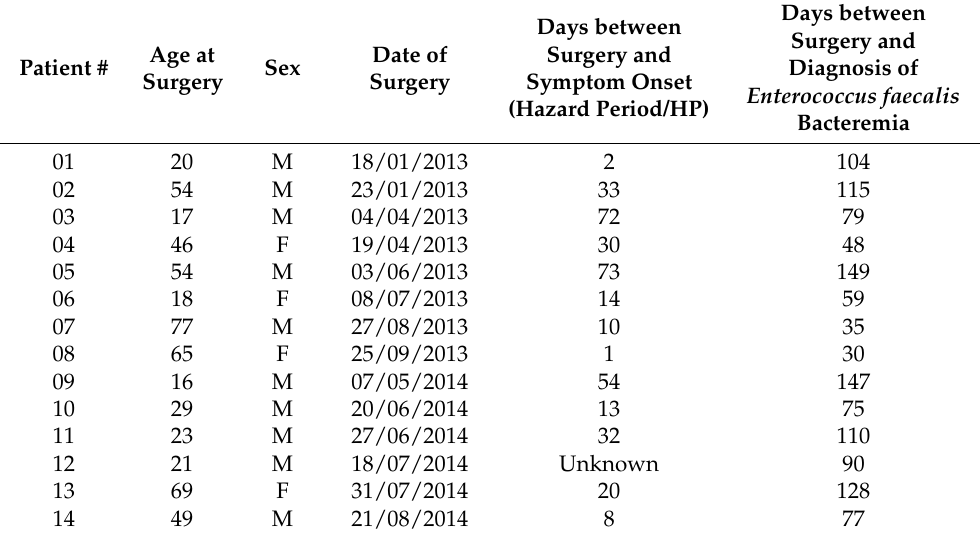
Table 2. List of age, sex, date of surgery, time between surgery and symptom onset (days), and time between surgery and diagnosis of bacteremia of the cases. Mrs. D is Patient #13